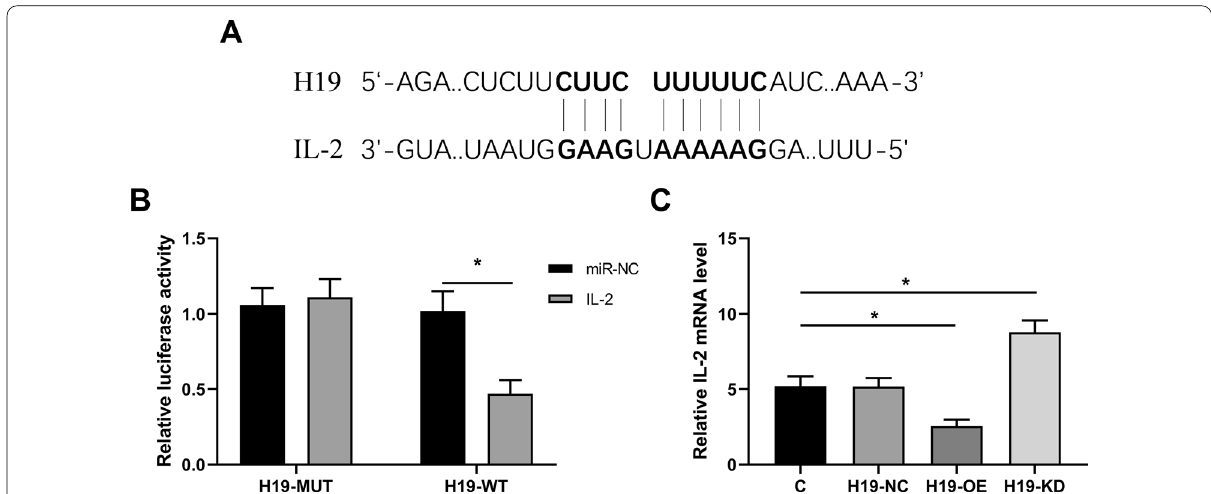
Fig. 5 H19 inhibited directly IL-2 transcription in BMMSCs. A The interaction between H19 and IL-2 was predicted by IntaRNA. B Luciferase-reporter assay indicated H19 bound with IL-2. C The effects of H19 on IL-2 mRNA level was analyzed by qPCR. *P <